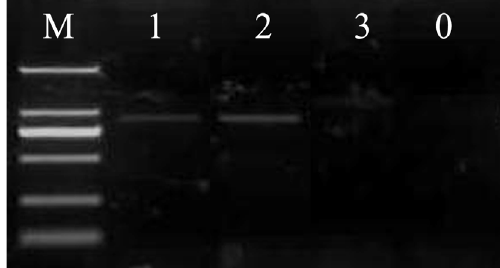
Fig. 2. The spcificity of the typical PCR; M: Marker(DL 2000); 1: Snit1; 2: Snit2; 3: Shal1; 0: Blank